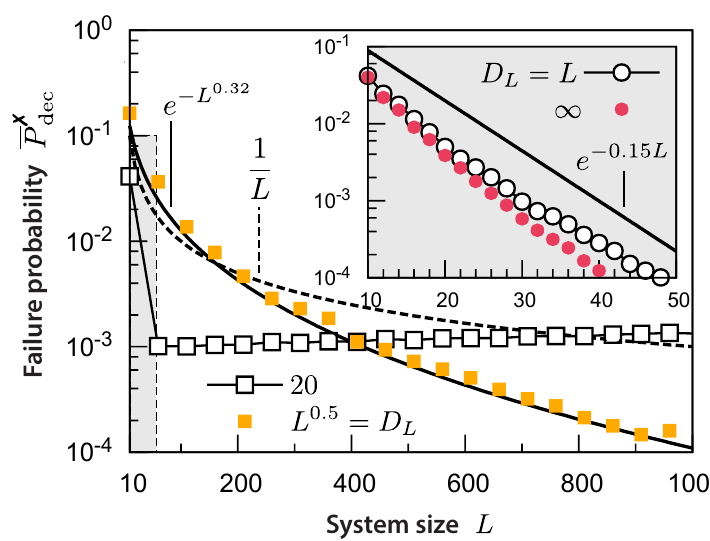
(cid:55) Figure 11: Failure probability for 2D-evolved TLV . Failure probability P of decoding error dec configurations with a 2D-evolved TLV-decoder of depth D as a function of the system size L for L (cid:55) = 0.2. Note that failed decodings include both syndrome-free states microscopic error rate p 0 with corrupted logical qubit and states with residual syndromes. We sampled 5 · 10 6 instances per data point. The gray rectangle (dashed boundary) is shown as inset. The solid and dashed lines show the analytic functions e − L 0.32 , 1 / L , and e − 0.15 L as a guide to the eye; these are neither = const = 20 (empty fits nor analytical results. We compare setups with constant-depth D L = L 0.5 (filled squares). Note that the curves intersect for squares) and sublinear-depth D (cid:112) L L = 400 because 400 = 20. The inset depicts the much faster decreasing cases of unbounded = ∞ (filled circles) and linear depth D = L (empty circles). There is no qualitative depth D L L difference between the two for the shown